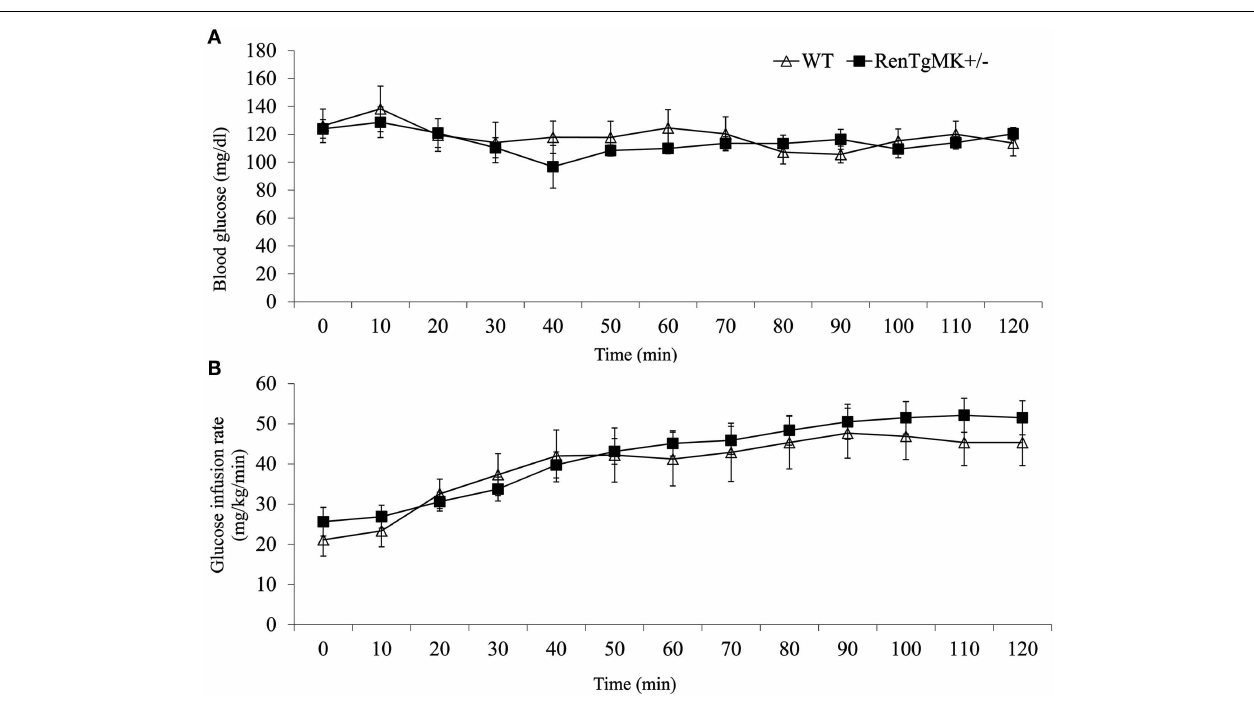
FIGURE 2 |Assessment of insulin sensitivity in male wild-type and RenTgMK + / − mice using hyperinsulinemic euglycemic clamp. Changes in blood glucose concentration (A) and glucose infusion rate (B) over time are shown.Values are means ± SE. Animals were approximately 9months old. n = 8–9 For WT; n = 7 for RenTgMK + / − .